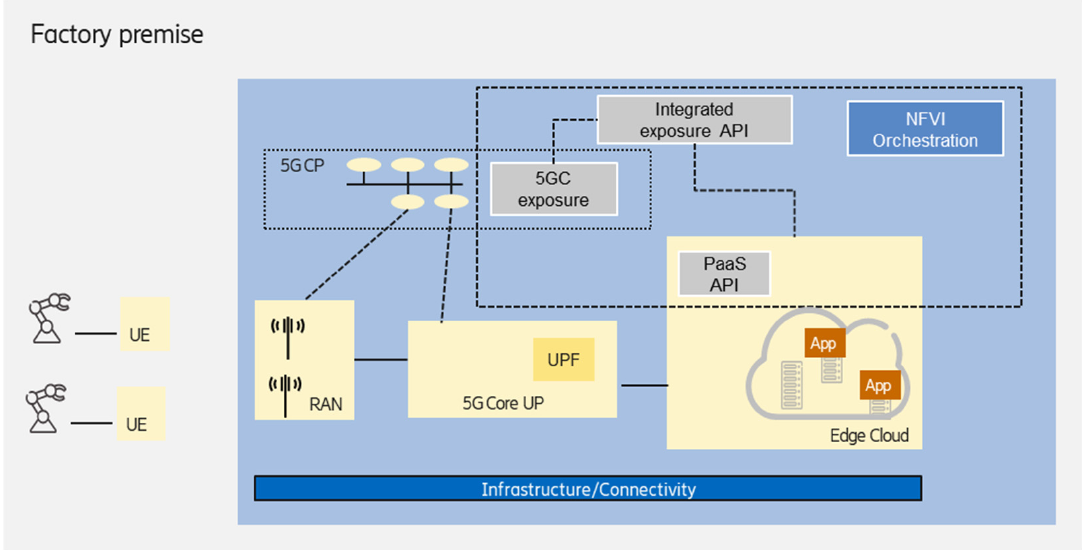
Figure 5. On-premises edge deployed using shared NPN infrastructure.